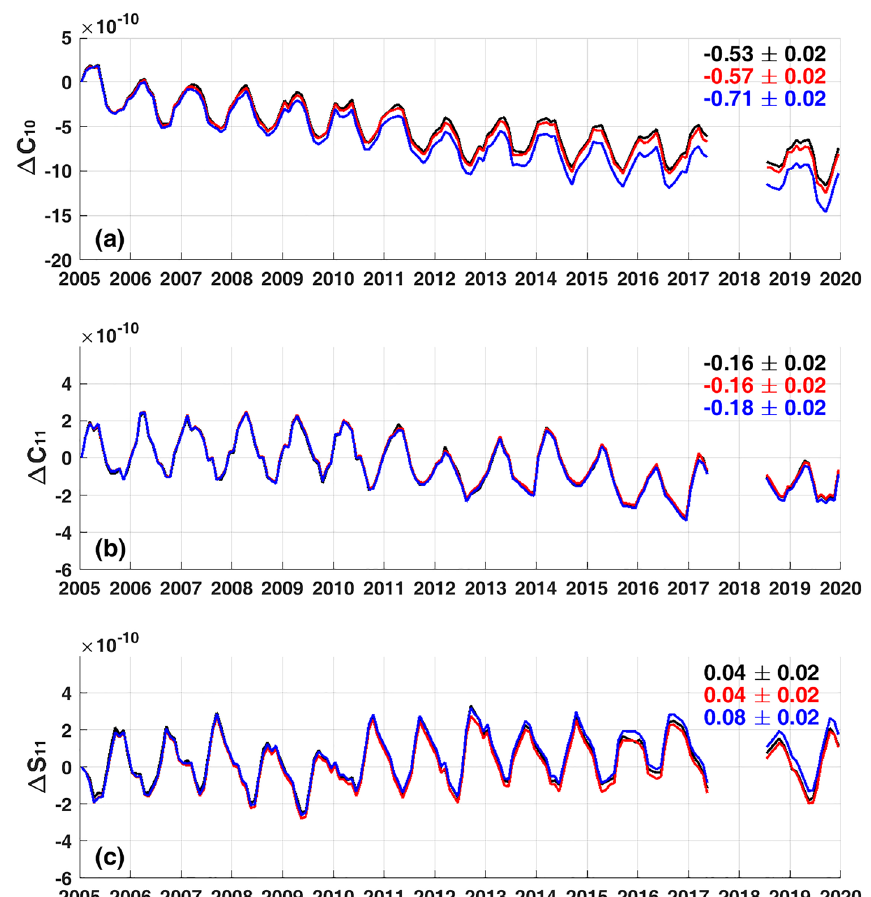
Figure 3. Degree-1 SH Coefficients. Gray lines are from TN13, and red and blue lines are estimated SH coefficients after GIA correction with Peltier et al. 17 and Caron et al. 20 , respectively. Numbers in each panel are linear trends with associated 95% confidence